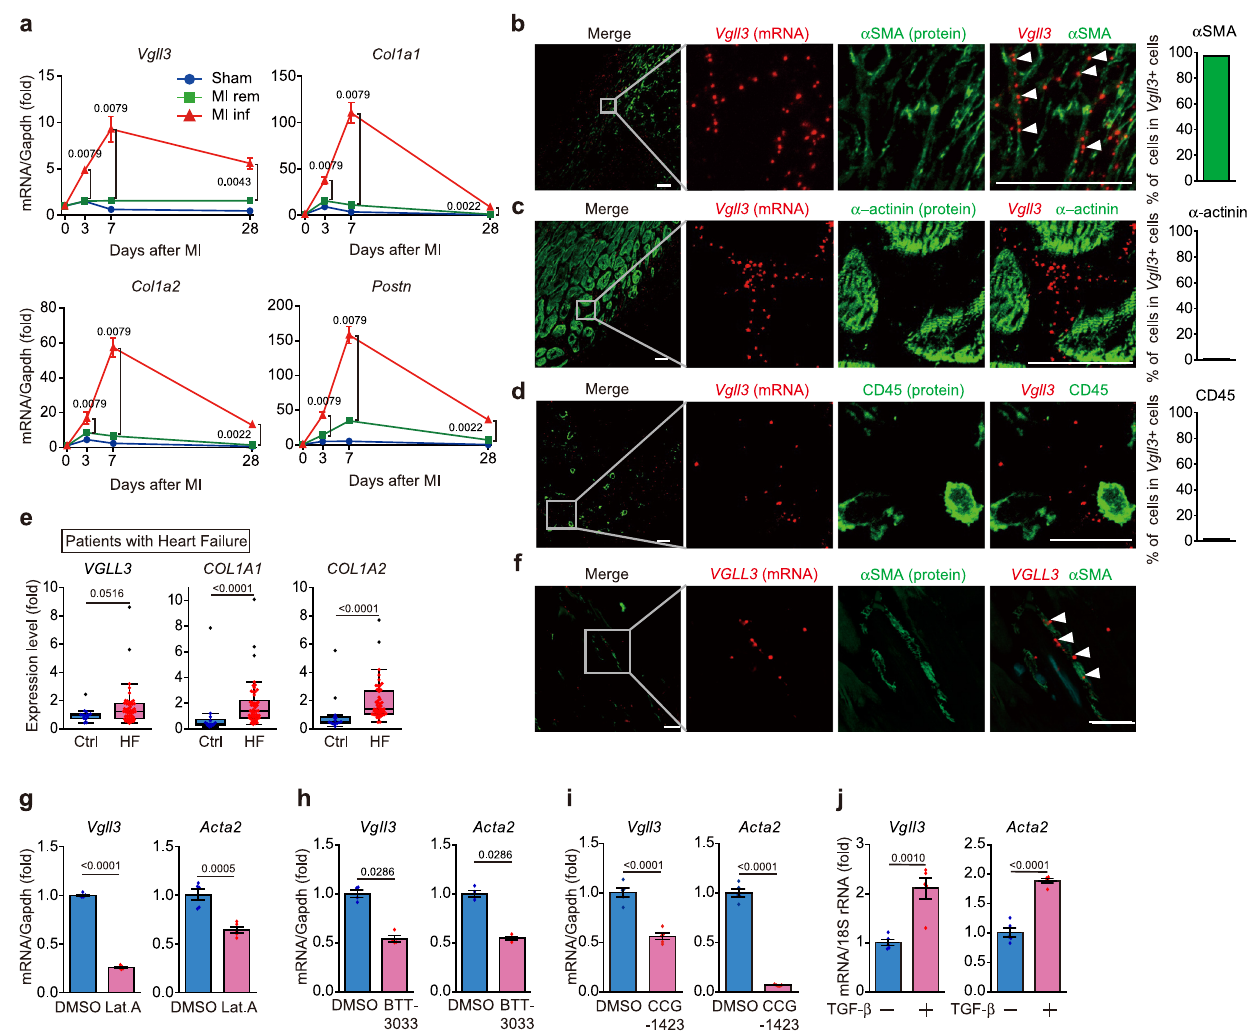
Fig. 2 | Vgll3 is induced in fi brotic heart and is speci fi cally expressed in myo- fi broblasts. a mRNA levels of Vgll3 and fi brosis-related genes in sham-operated mouse hearts (sham), and in the remote (rem) and infarcted (inf) areas of mouse heartsaftermyocardialinfarction(MI)( n =3 – 6hearts/group). b – d Co-detectionof Vgll3 mRNA and α SMA ( b ), α -actinin ( c ) and CD45 ( d ) in the left ventricle of MI murine hearts on day 7. Percentage of cells positive for each marker protein in Vgll3 +cells is shown in each graph (n>100 cells). e mRNA levels of VGLL3 and fi brosis-relatedgenesintheheartsofcontrolindividuals(Ctrl)( n =14)andpatients with heart failure (HF) ( n =50) based on data from GSE116250. f Co-detection of VGLL3 mRNAand α SMAintheleftventricleofpatientswithMI. g – i Vgll3 and Acta2 mRNAlevelsincardiacmyo fi broblaststreatedwithLat.A(2 μ M)for4h( n =5each) ( g ),BTT-3033(15 μ M) for 12h ( n =4 each) ( h ) and CCG-1423 (10 μ M) for 24h ( n =5